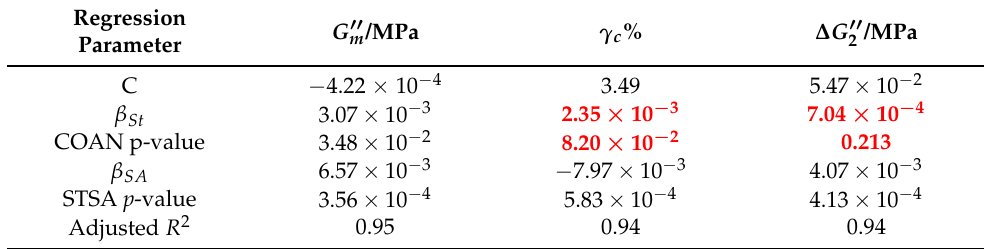
Table 9. Regression analysis of G (cid:48)(cid:48) fitting parameters.